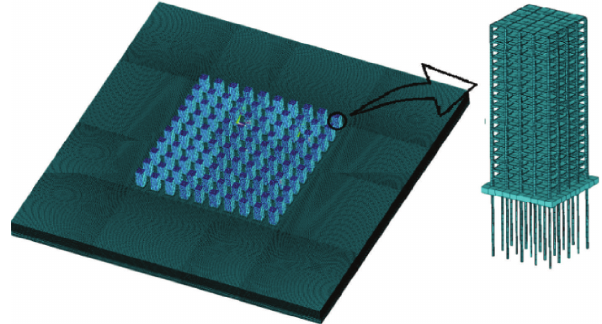
Figure 1: 3D finite element